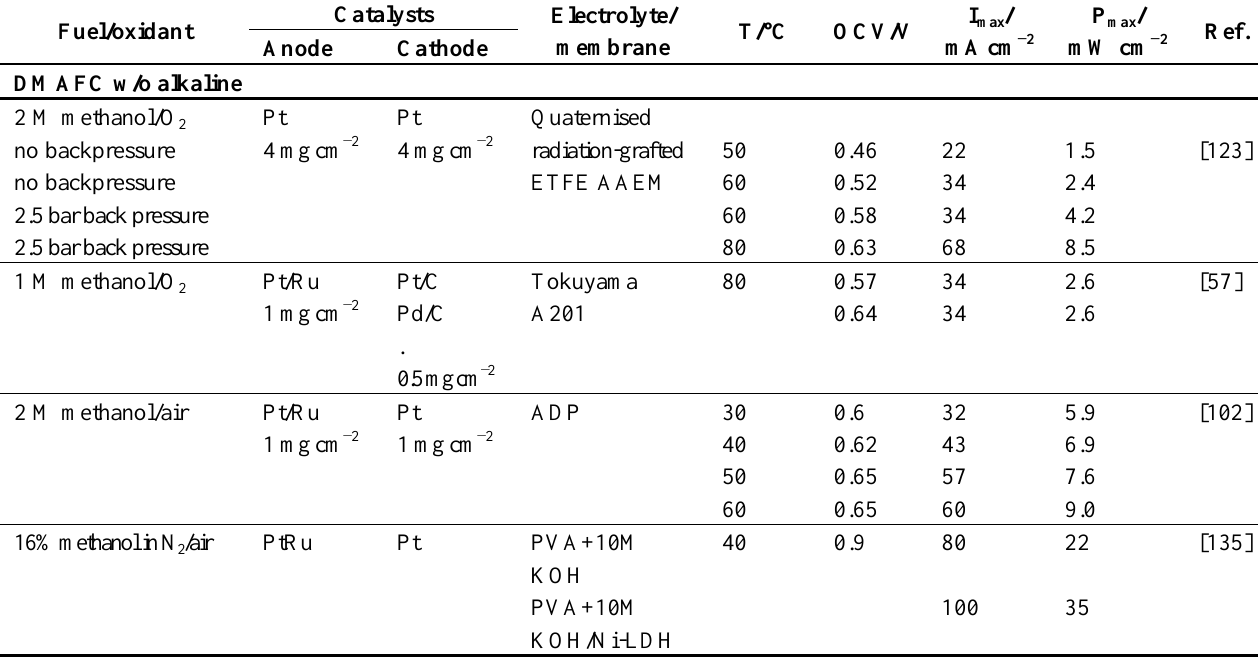
Table 5. Summary of DAAFC